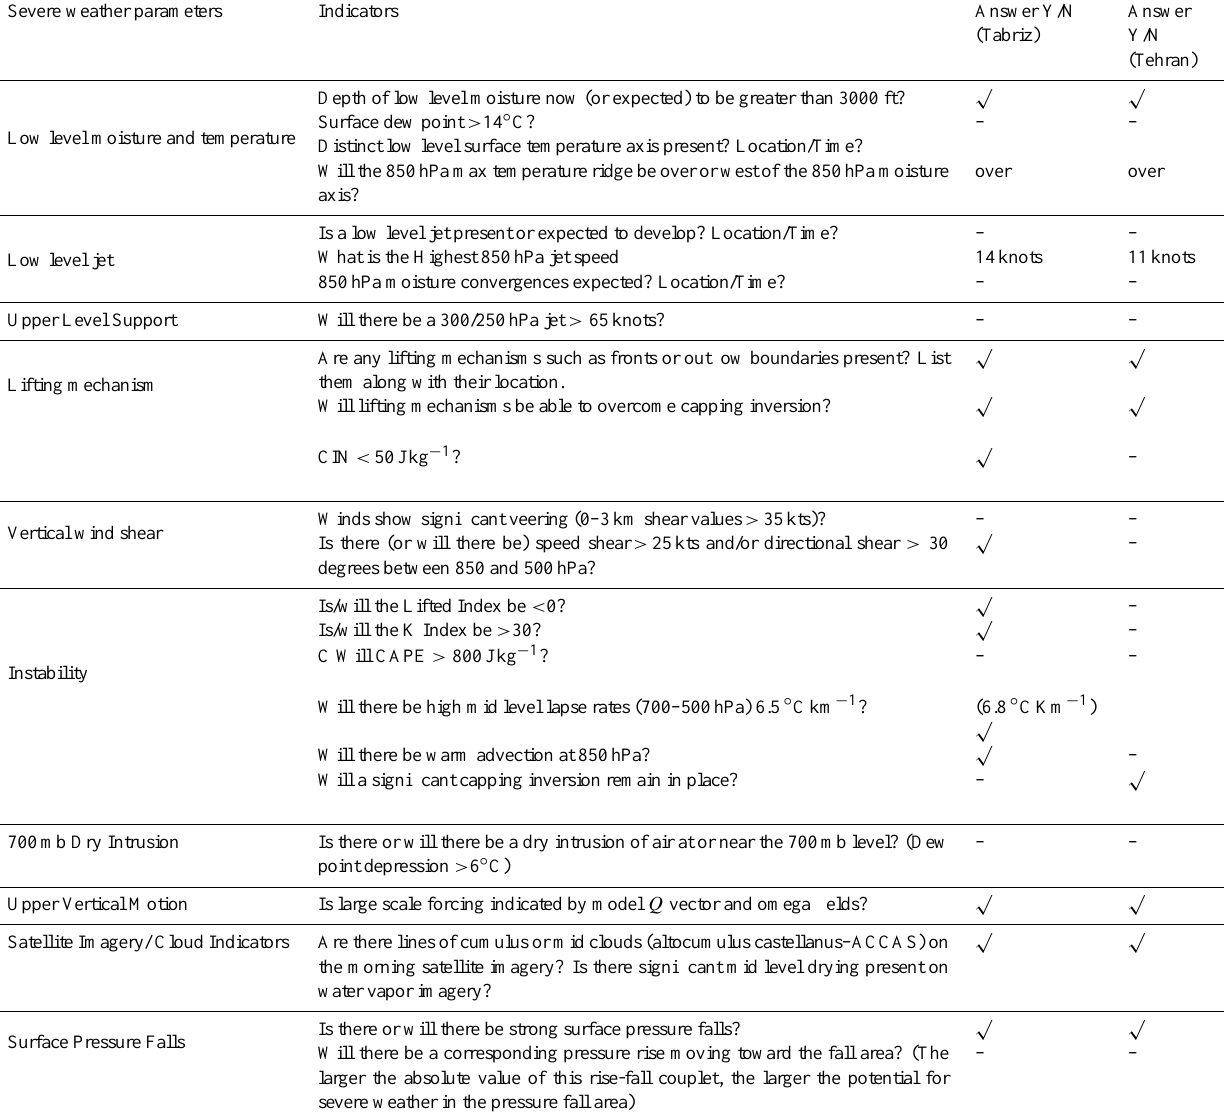
Table 3. Gordon severe weather check list for Tehran and Tabriz stations on 30 March